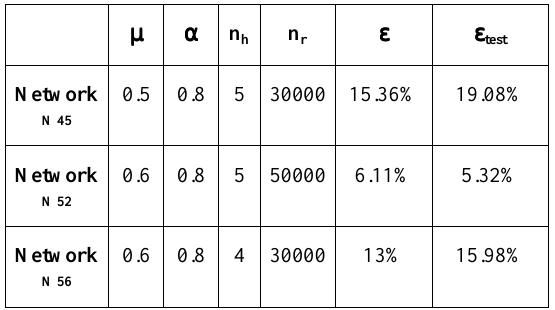
Table 4.3: Networks parameters and performances.